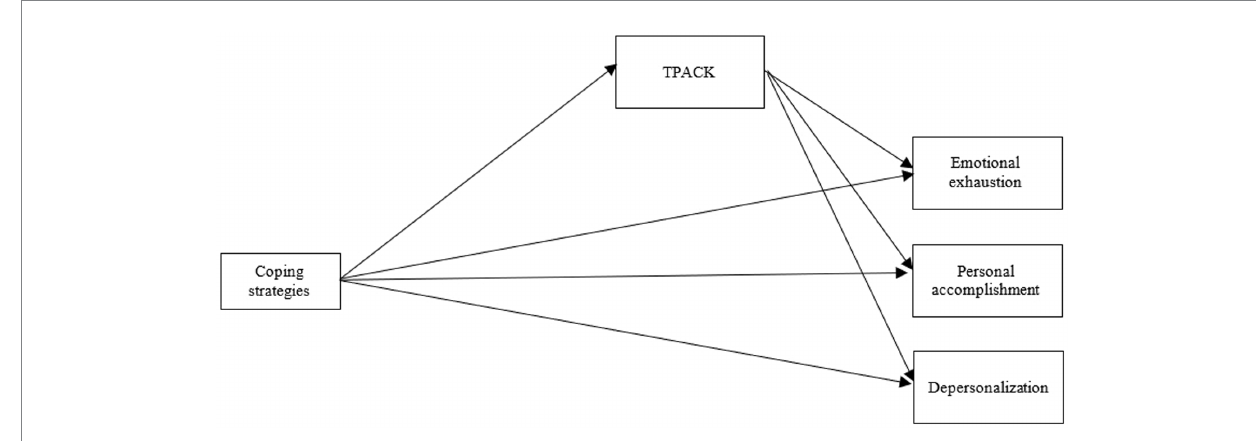
FIGURE 1 The model of the